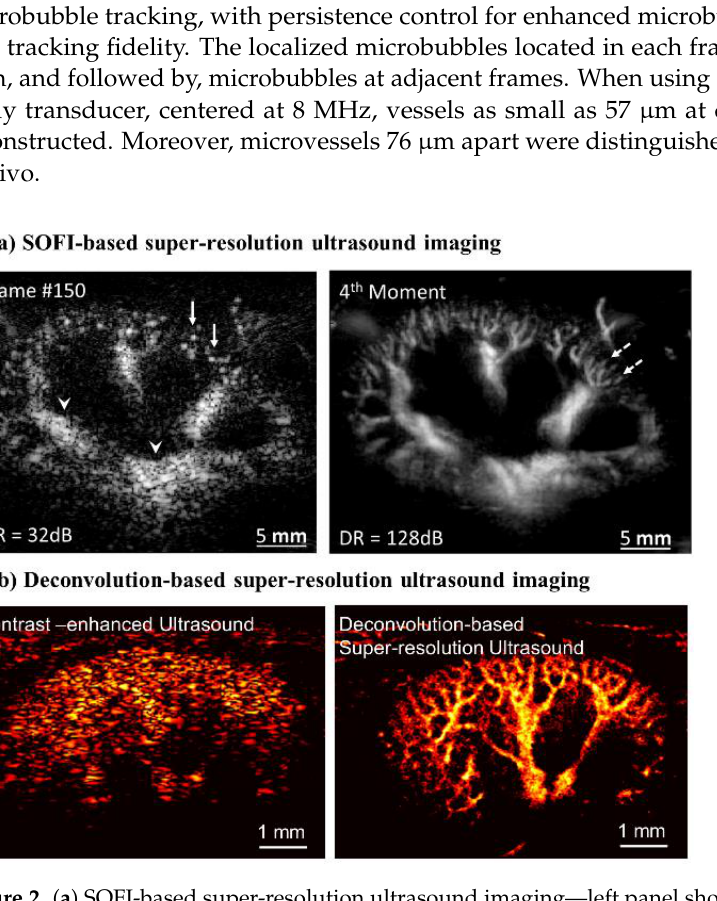
Figure 2. ( a ) SOFI-based super-resolution ultrasound imaging — left panel shows a frame of B-mode; right panel shows the reconstructed image. (Reprinted with permission from ref. [43]. Cop- yright 2017 IEEE). ( b ) Deconvolution-based super-resolution ultrasound imaging — left panel shows a frame of B-mode; right panel shows the reconstructed image. (Reprinted with permission from ref. [45]. Copyright 2020 Elsevier).